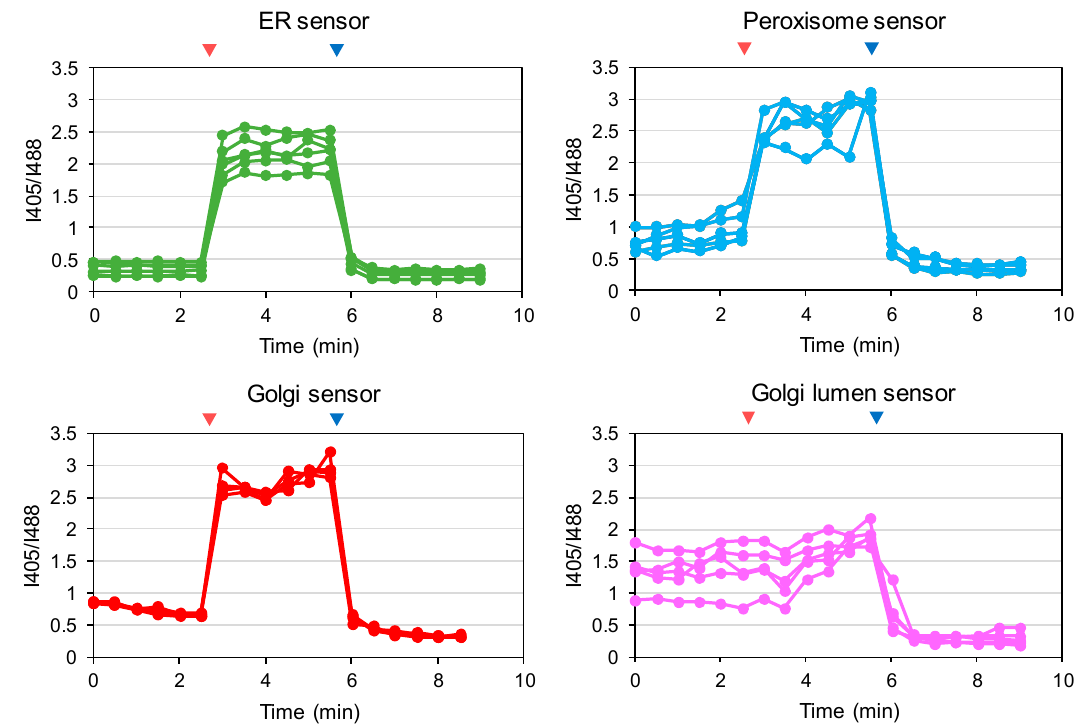
Figure 5. Validation of the redox reactivity of constructed sensors in HeLa cells. Reversible redox modulation was confirmed by sequential treatment with H 2 O 2 (oxidant, red arrow heads) and 5 mM DTT (reductant, blue arrow heads). Based on the results of H 2 O 2 titration, actin and peroxisome sensors were tested by 2 mM H 2 O 2 while others were assayed with 0.5 mM H 2 O 2 . Blue and red arrow heads represent the time of adding H 2 O 2 and DTT, respectively.